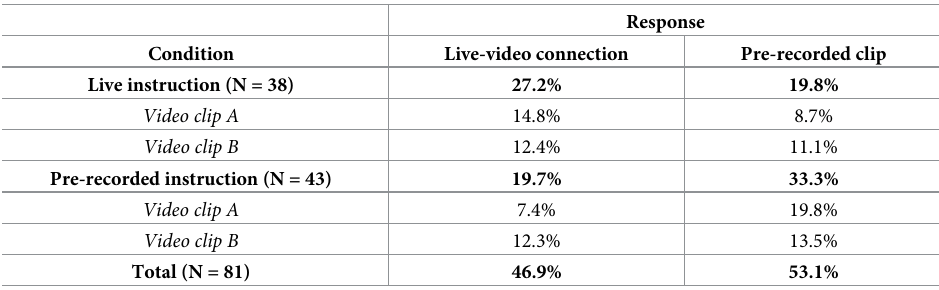
Table 1. Participants’ responses (N =